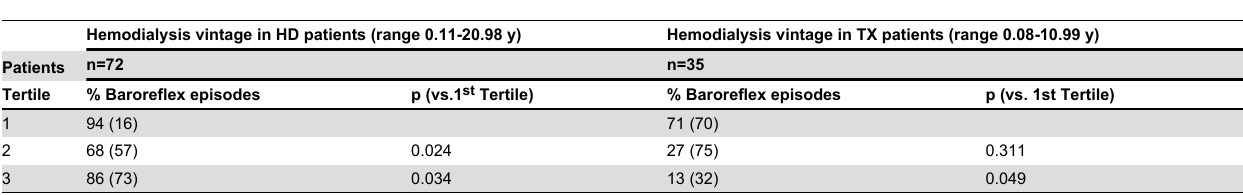
Table 3. Effect of hemodialysis vintage on the baroreflex contribution (% baroreflex episodes) in hemodialysis (HD) and in transplanted (TX)